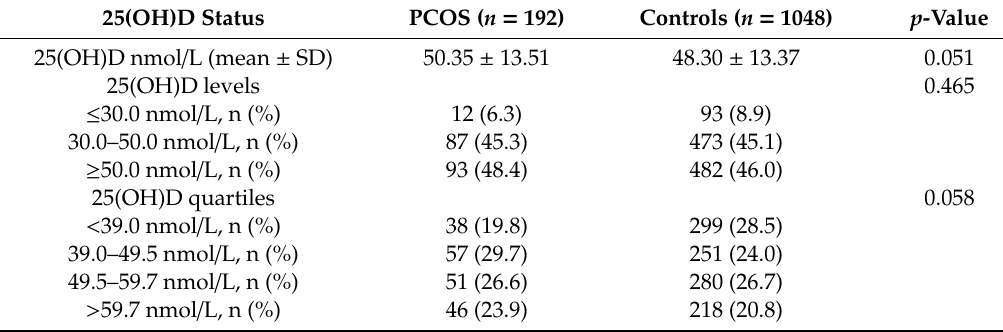
Table 2. Serum 25-hydroxyvitamin D (25(OH)D) levels and distributions in women with polycystic ovary syndrome (PCOS) and non-PCOS